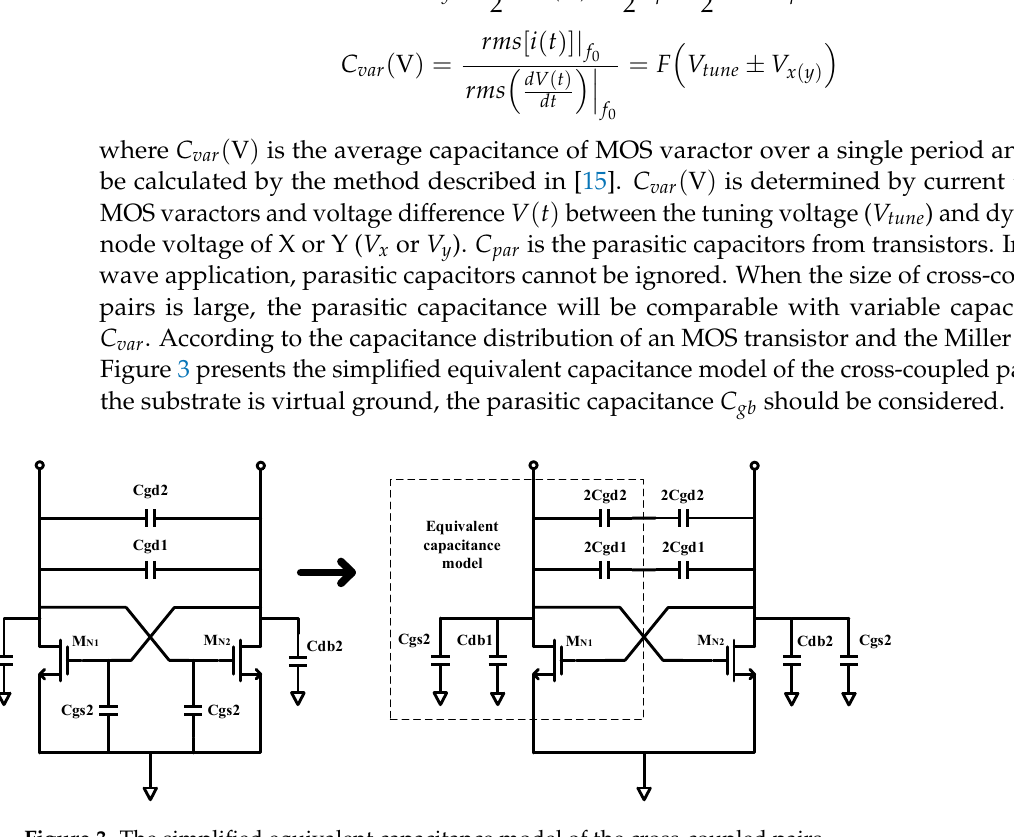
Figure 3. The simplified equivalent capacitance model of the cross-coupled pairs.